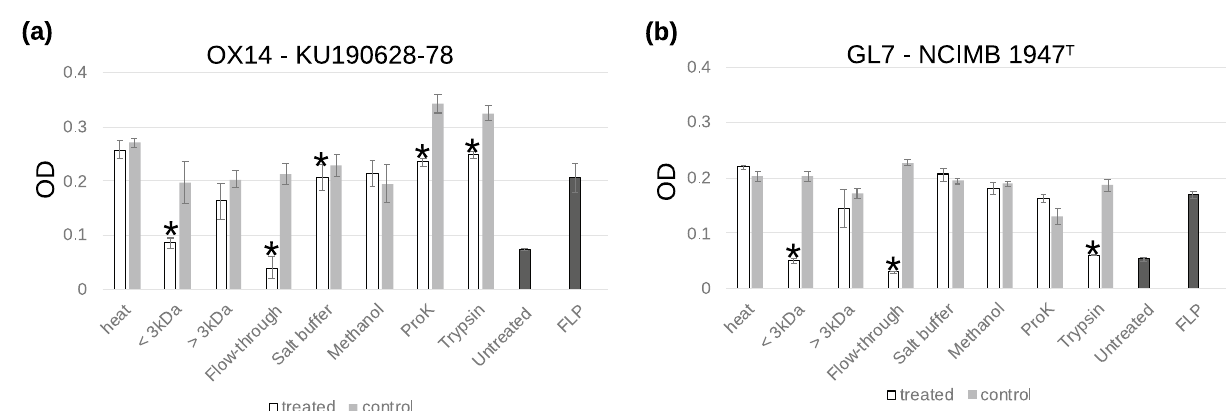
Figure 3. Antagonistic activity of bacterial culture supernatants against F. psychrophilum at various growth phases . Growth activities of ( a ) OX14 and ( b ) GL7 strains against F. psychrophilum KU190628-78 and NCIMB 1947 T , respectively, at mid and late exponential growth, and stationary phases. Growth of positive control, in the absence of the supernatant, is taken as 100% (OD values of positive controls are 0.2 for KU190628-78 and NCIMB 1947 T ). Bars, standard deviation of triplicate samples. *Statistically significant decrease ( p < 0.05).